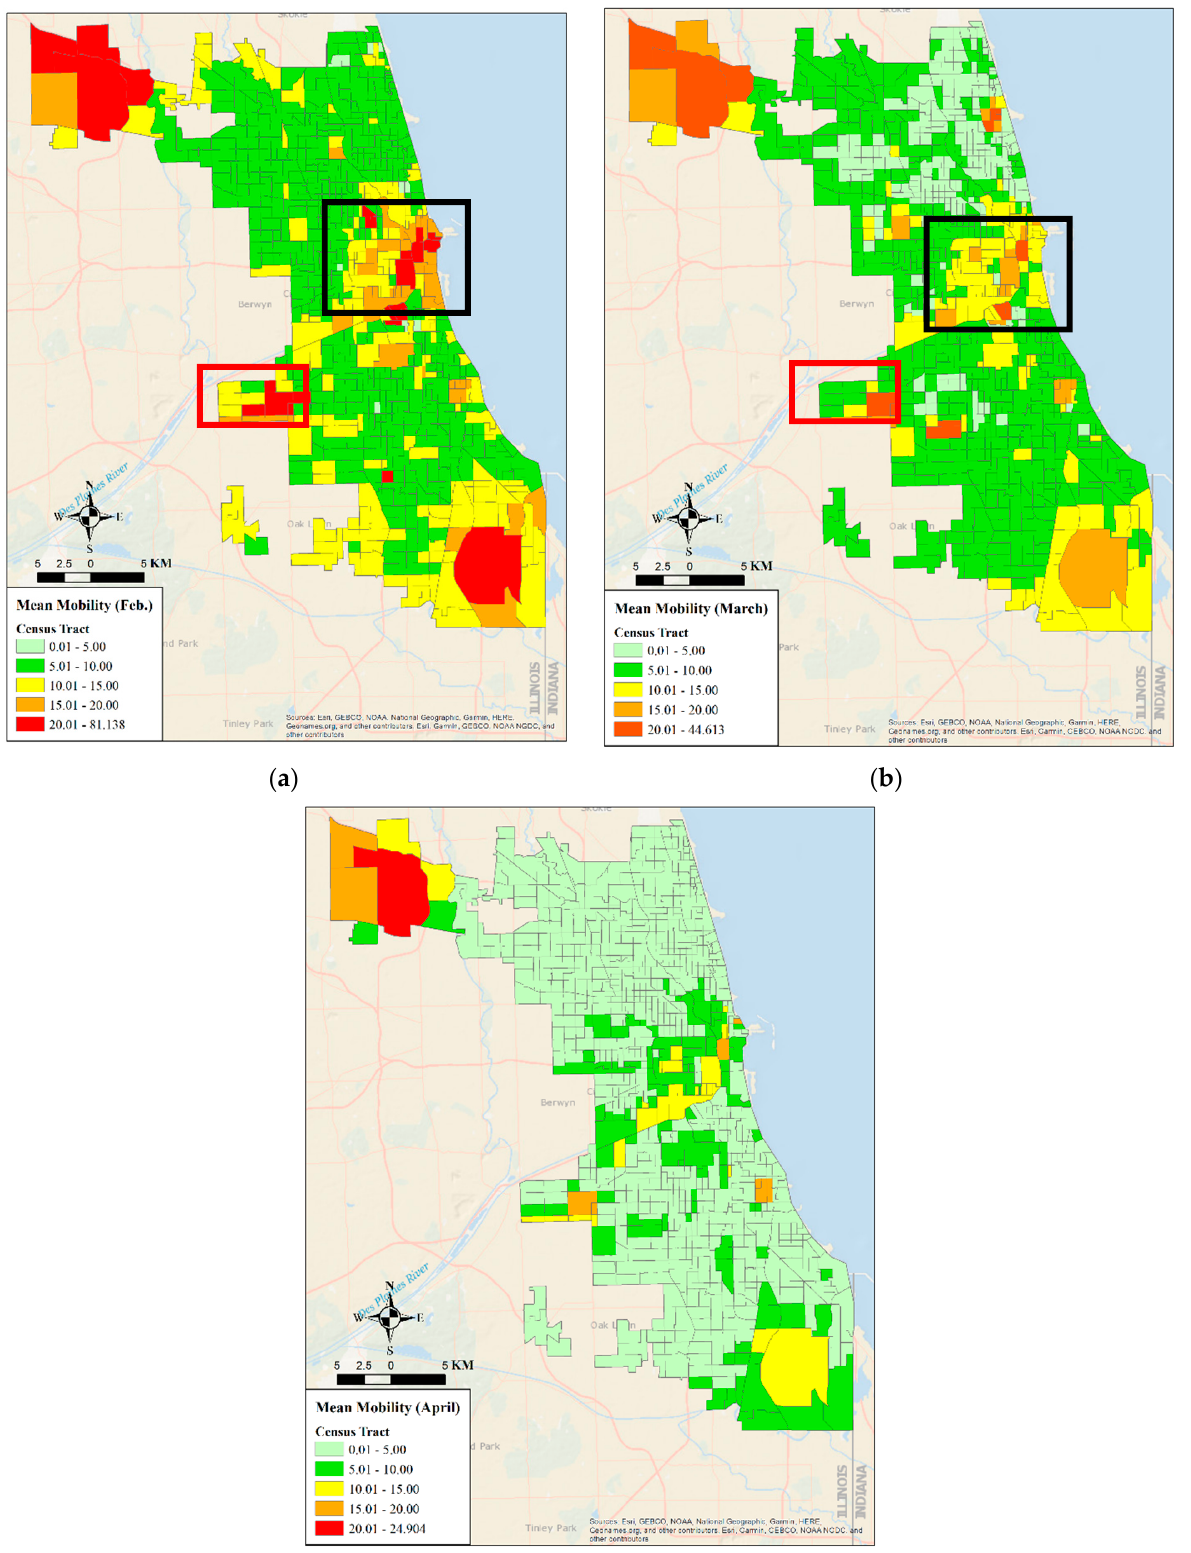
Figure 7. Mean mobility distribution in Chicago in February ( a ), in March ( b ), and April ( c ).